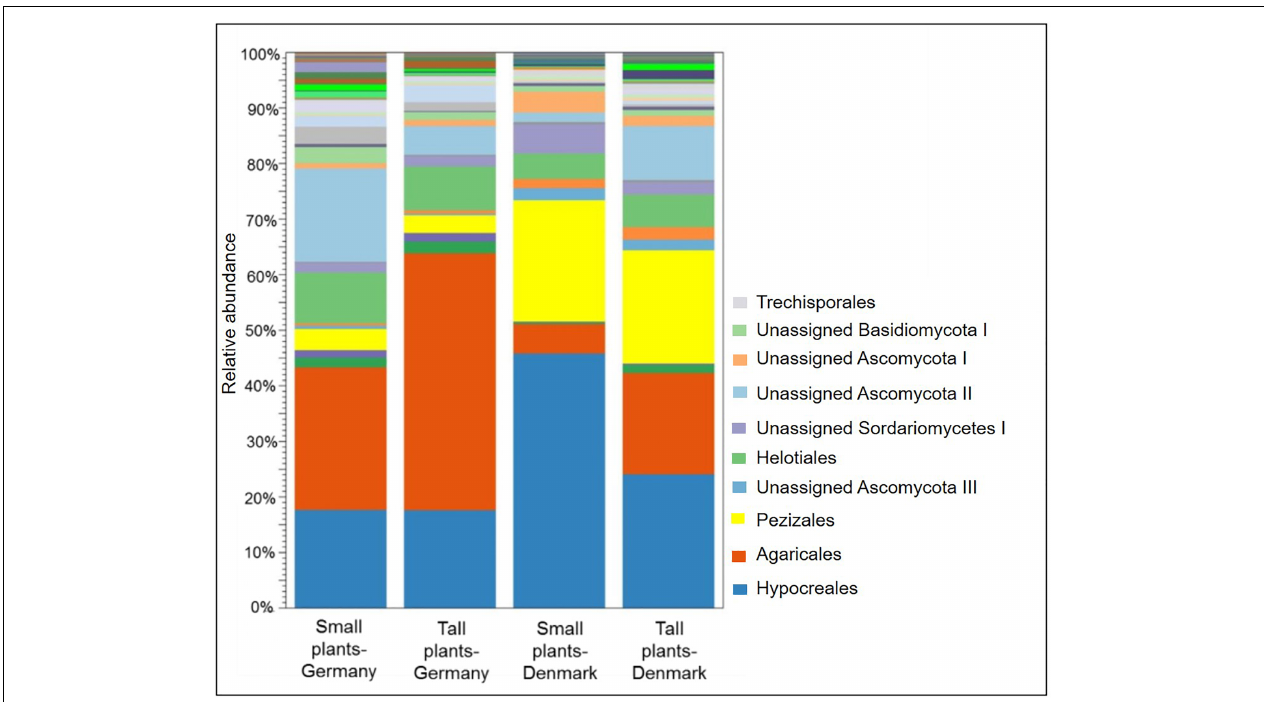
FIGURE 6 | Stacked bar plot showing relative abundances of fungal order in the rhizosphere of tall and small A. nordmanniana plants from German and Danish sampling sites. Plots are based on sequencing data for 18S rRNA genes.